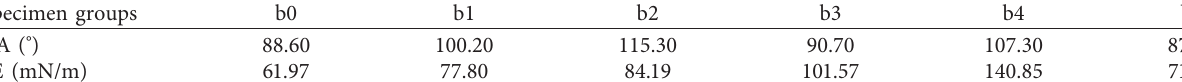
Table 8: Measured values of the CA and SE.